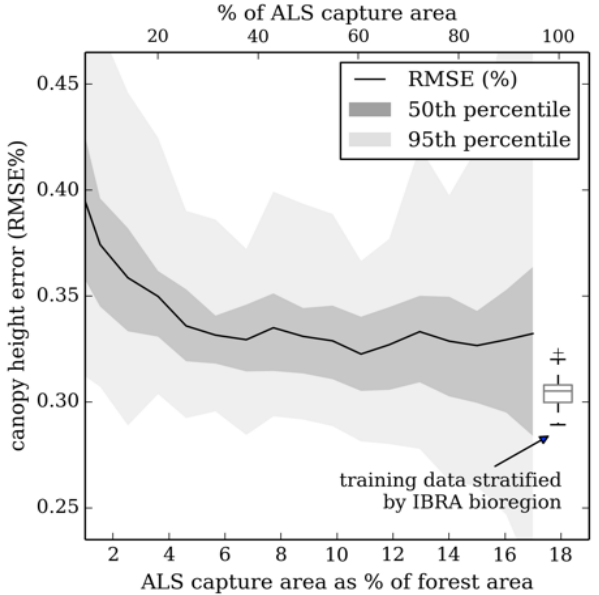
Figure 9. Error in canopy height estimates when constructing random forest models from ALS data selected to represent a combination of a number of disparate (non-random) acquisitions. Model output was validated with ALS plots from outside the training area. For comparison (see boxplot), the results from bootstrapping ( N = 50) random forest trained with a random stratified (by IBRA bioregion) sample from across the whole study area (~18% of forested area) is